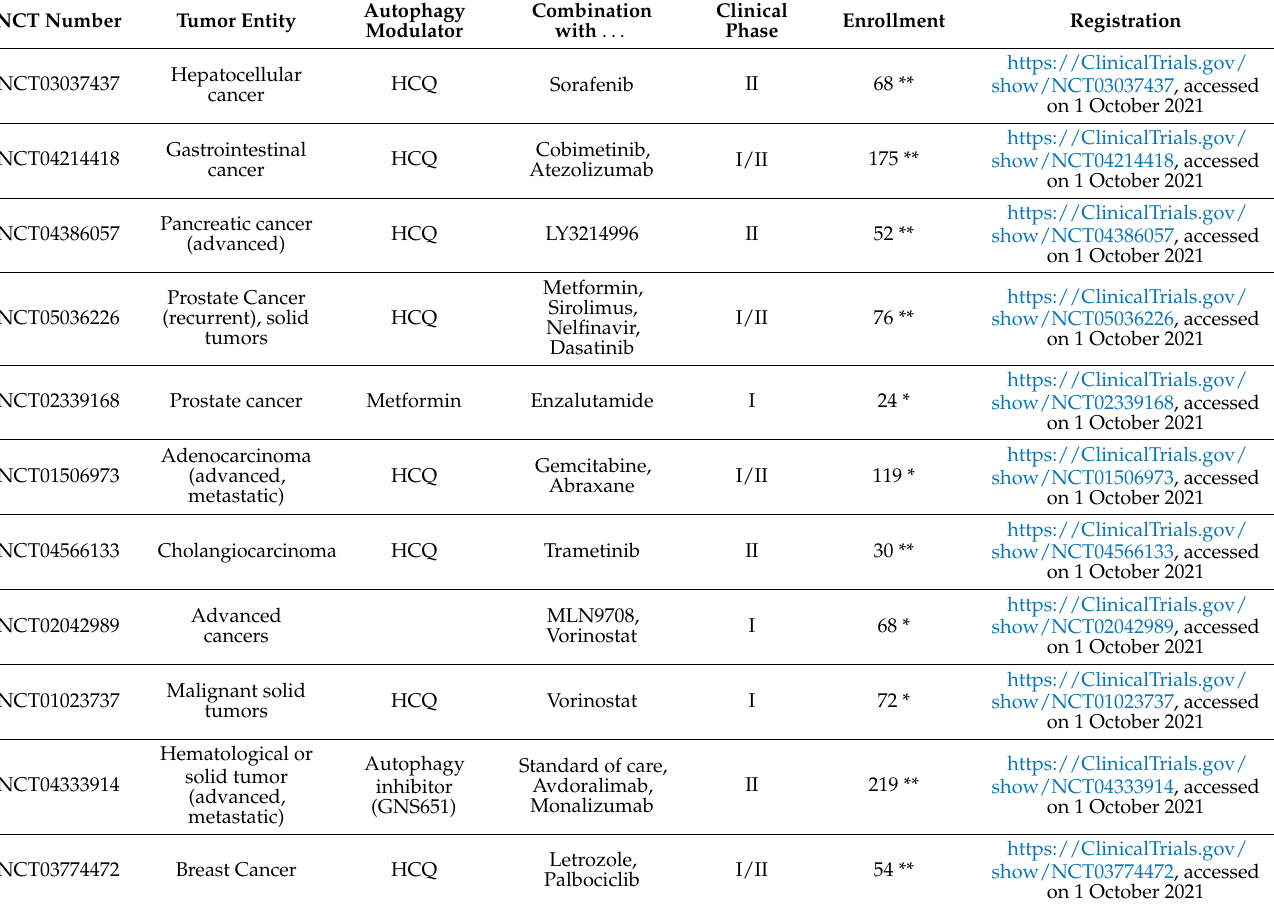
Table 3. Selected ongoing interventional trials listed on ClinicalTrials.gov (* actual and ** estimated